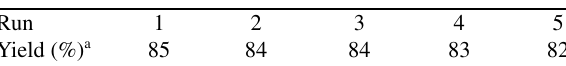
Table 3 . Recycling of ZrOCl of 4b.